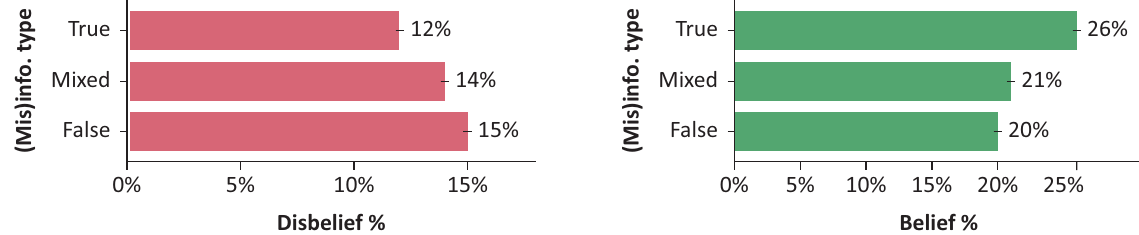
Figure 2. Prevalence of dis/belief for true, mixed, and false claims on social media. Notes: For disbelief (left graph), as the veracity of the claims decreases, the prevalence of expressed disbelief increases. For belief (right graph), as the veracity of the claims decreases, the prevalence of expressed belief also